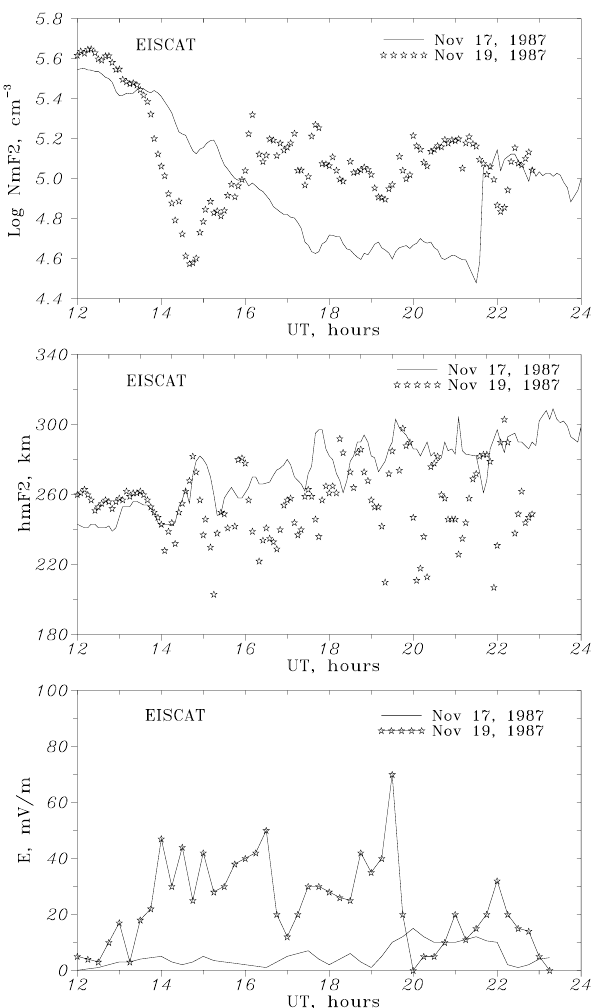
Fig. 4. Observed with EISCAT diurnal variations of NmF2, hm F2 and electric fields for quiet 17 November 1987 and disturbed 19 November 1987 days.